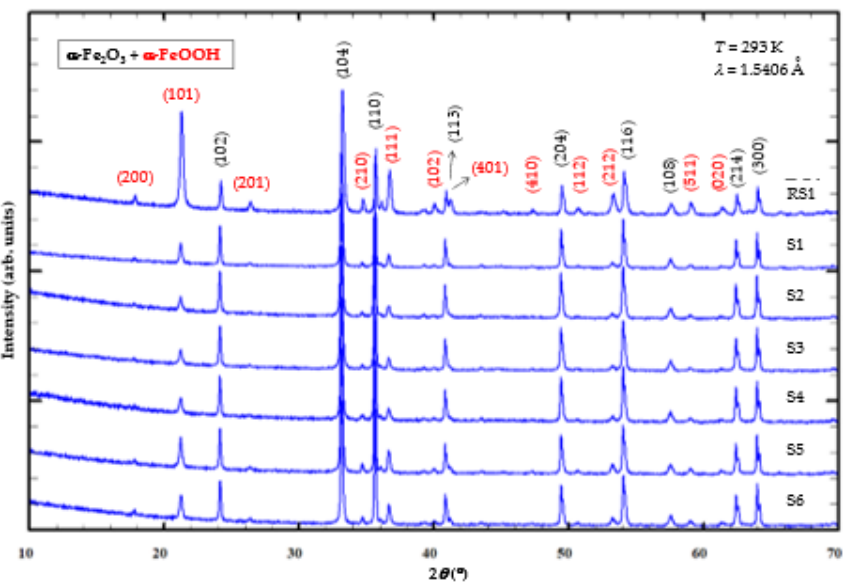
Figure 4. Cascade PXRD patterns of reference sample RS1 and samples S1–S6, prepared with addition of surfactants at 200 °C.